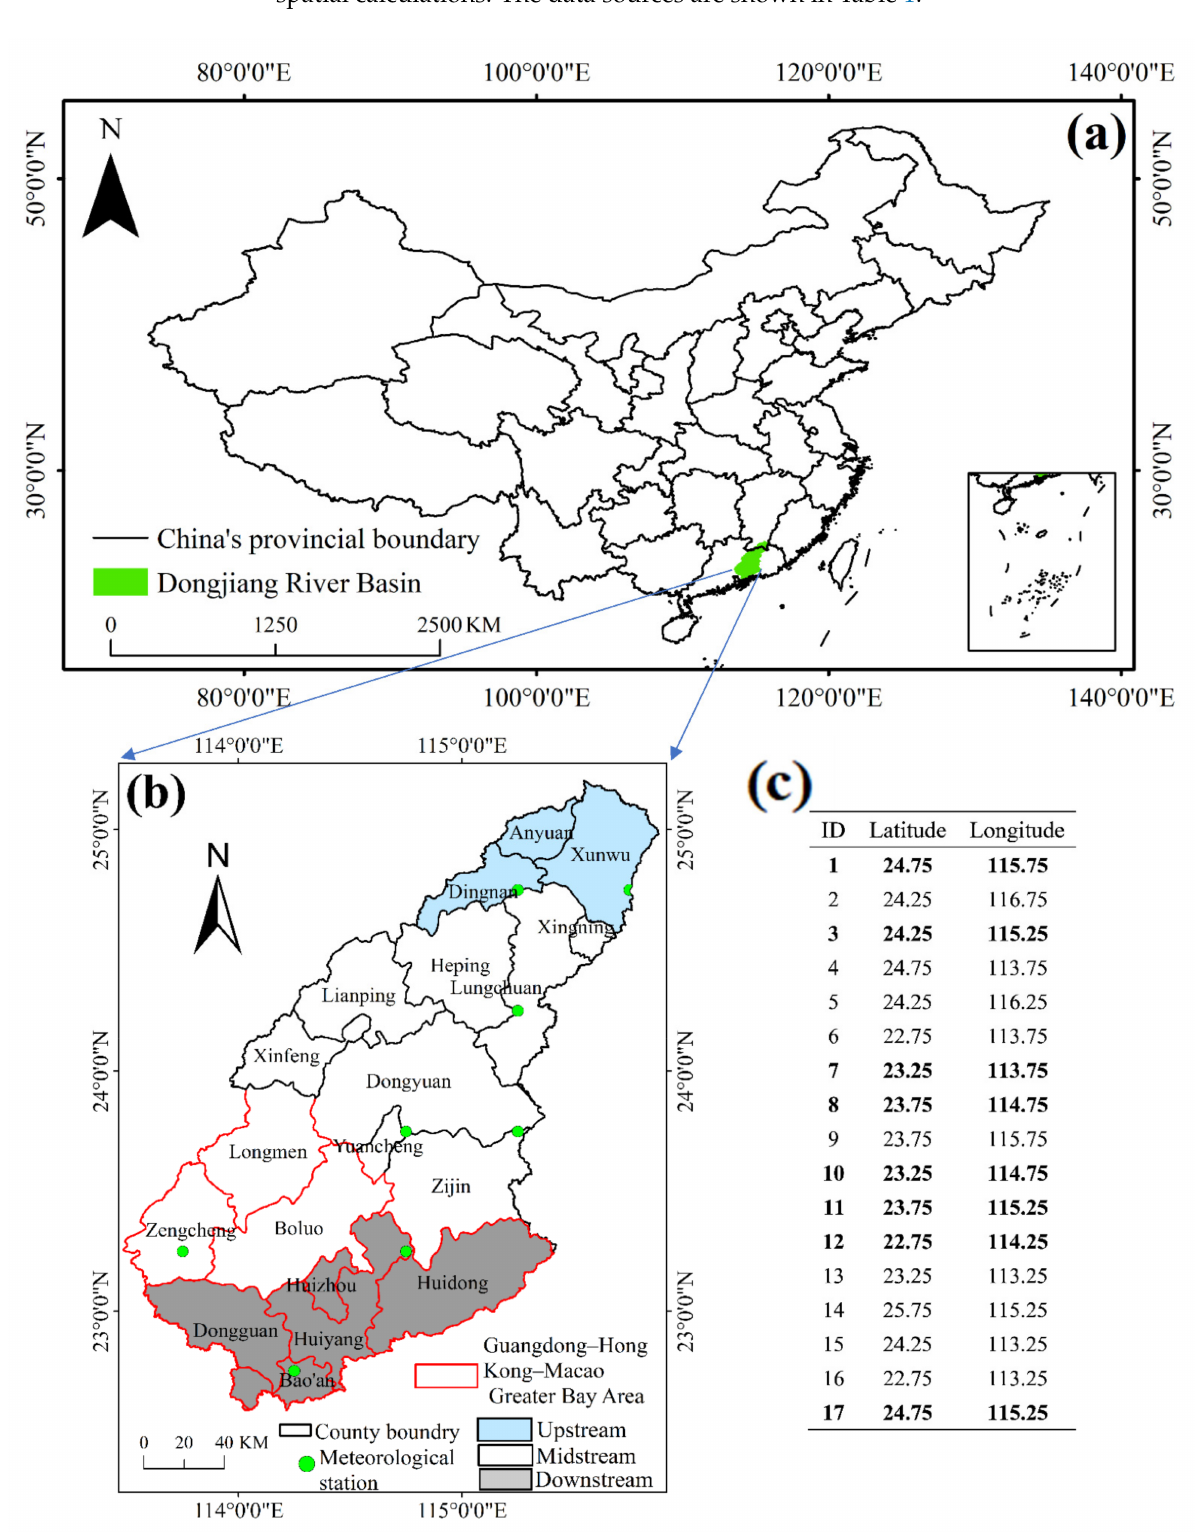
Figure 2. Study area. ( a ) Location of the study area in China; ( b ) The extent of the DRB; ( c ) The geographical location of meteorological stations. (The meteorological stations marked in bold are located within the DBR, and the meteorological stations not marked in bold are located outside the